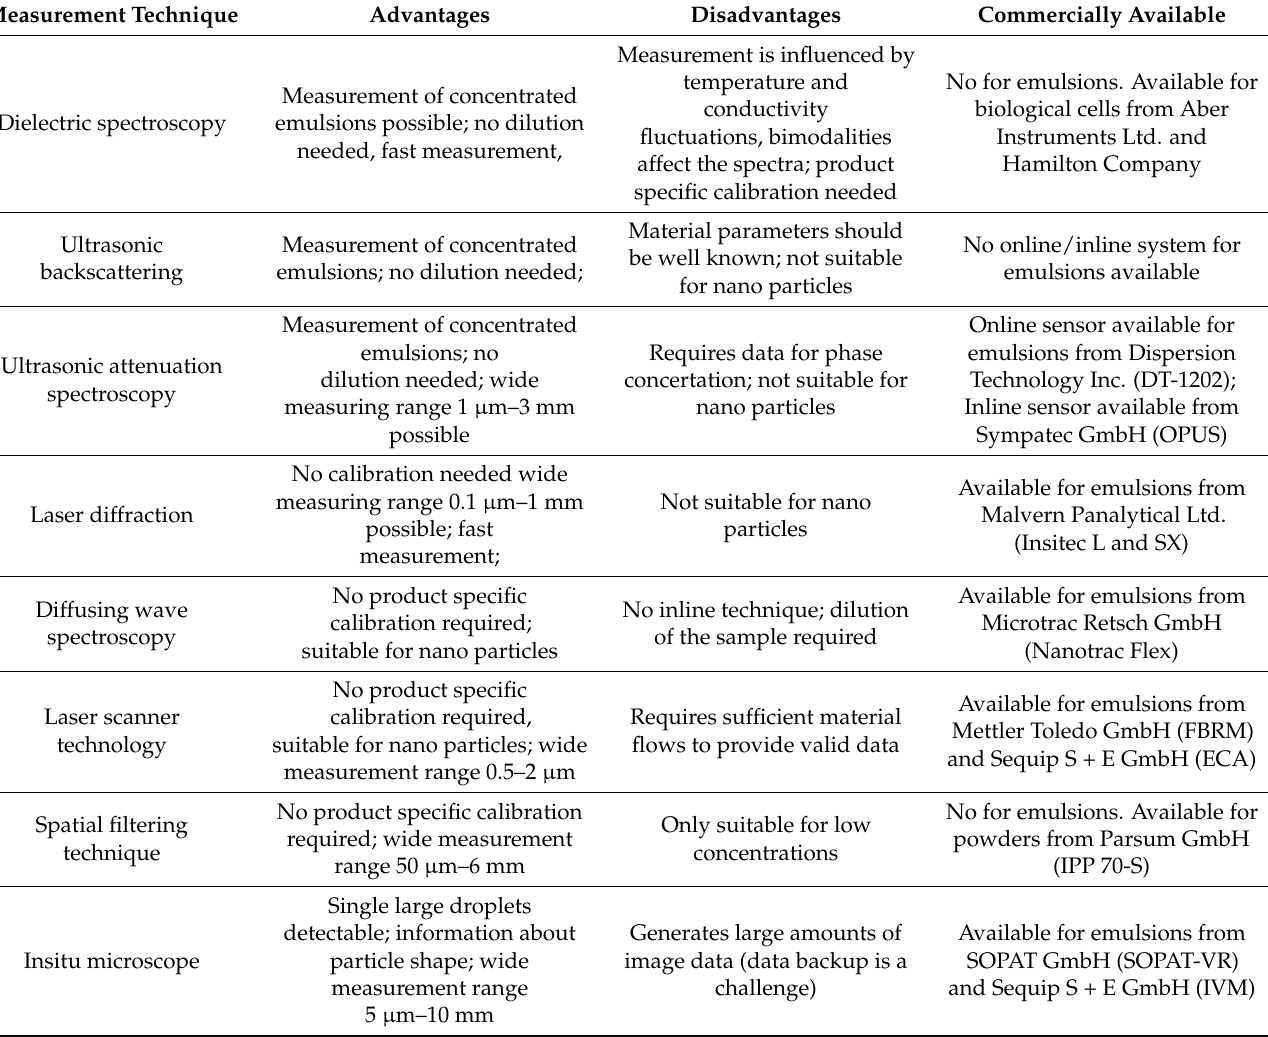
Table 1. Overview of PAT tools for droplet